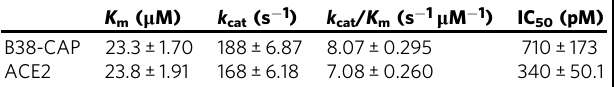
Table 1 Kinetic constants for hydrolysis of ACE2 substrate by B38-CAP and IC 50 of MLN-4760, an ACE2